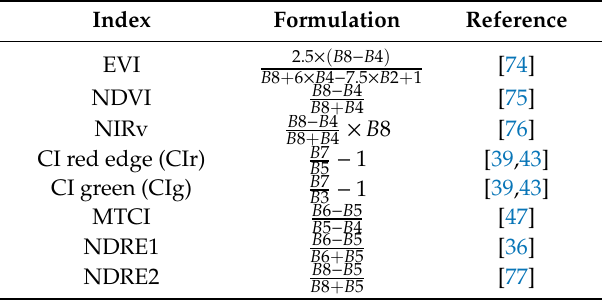
Table 2. Vegetation indices derived from the Sentinel-2 multispectral instrument (MSI) sensor. The terms B2 to B8 are the abbreviations of band reflectance from the Sentinel-2 MSI sensor. The center wavelength of each band is as follows: B2 (490 nm), B3 (560 nm), B4 (665 nm), B5 (705 nm), B6 (740 nm), B7 (783 nm), B8 (842 nm). EVI—enhanced vegetation index; NDVI—normalized di ff erence vegetation index; NIRv—near-infrared reflectance of terrestrial vegetation; CI—chlorophyll index; MTCI—medium- of the red